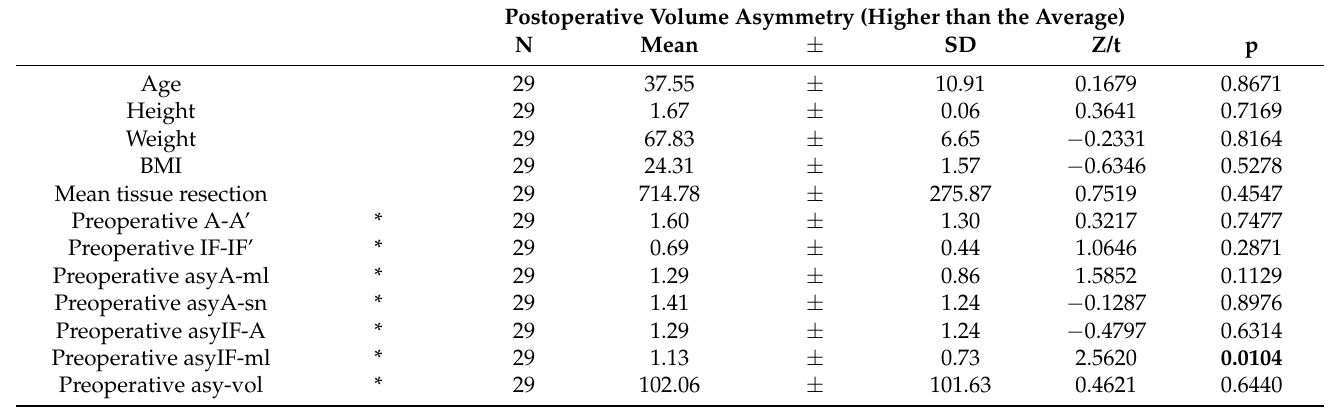
Table 5. Comparison of clinical and metric variables in women with postoperative (6 months after breast reduction) volume asymmetry higher than the average (52 cc) versus lower than the